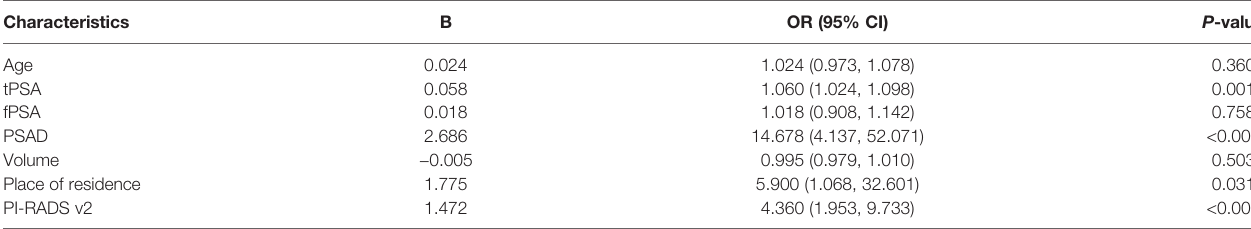
TABLE 3 | Results of logistic regression